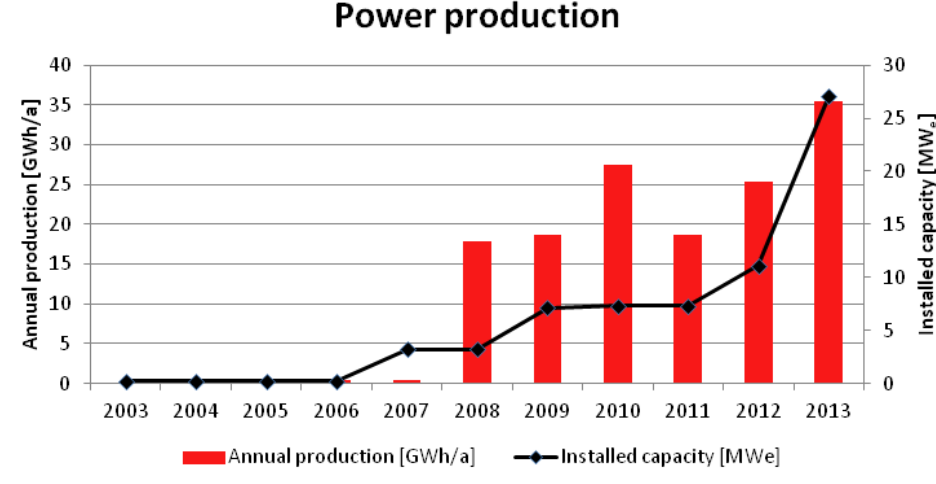
Figure 8. Geothermal direct use (spas and district heating) in